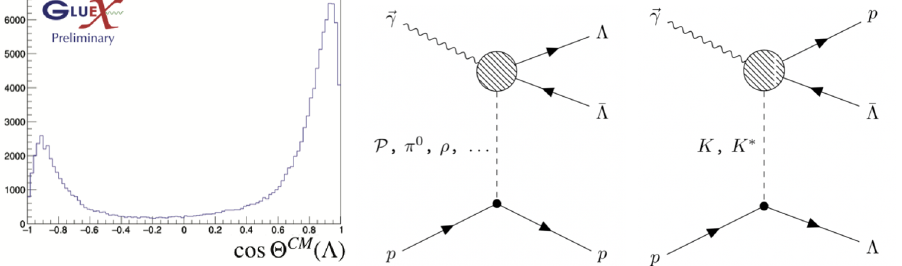
Figure 1. The left panel shows the cos θ distribution of Λ in the center-of-mass frame for the reaction γ p → Λ ¯ Λ p . The forward and backward peaks can be explained by the two possible production mech- anisms shown to the right of it. The middle panel shows the Λ ¯ Λ pair being produced at the top vertex recoiling against a proton. The right panel depicts a process in which strangeness is exchanged and a p ¯ Λ pair is produced at the top vertex recoiling against a Λ . All taken from Ref. [3].